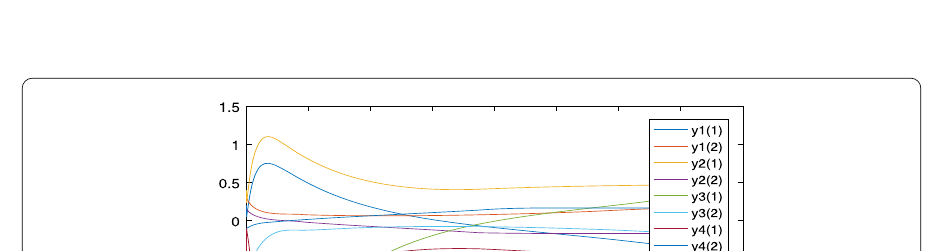
Figure 1 State trajectory of (4.1) without control